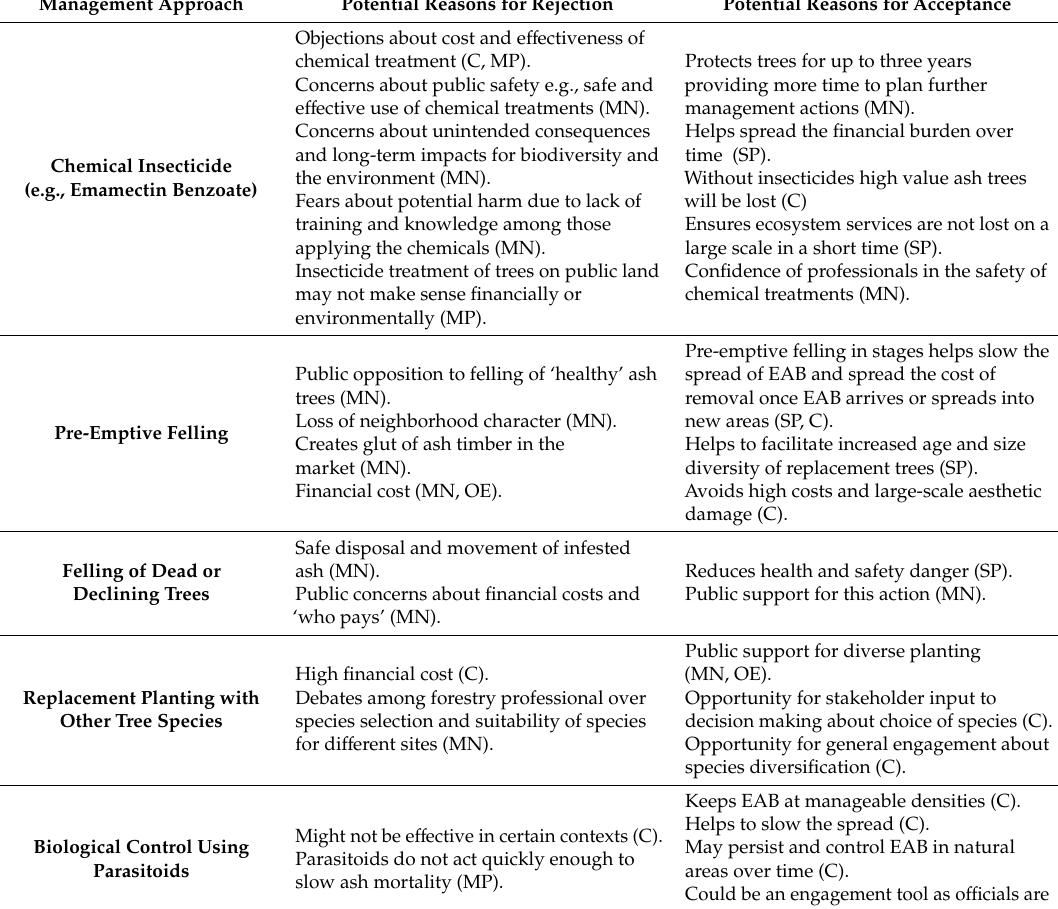
Table 2. Summary of management approaches and potential reasons for acceptance or